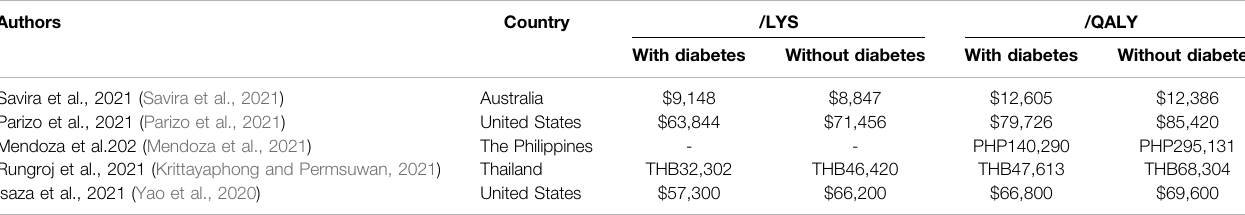
TABLE 3 | Subgroup analyses of diabetes